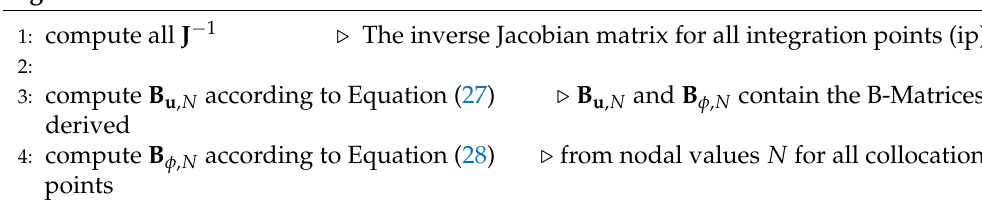
Algorithm 1 Collocation